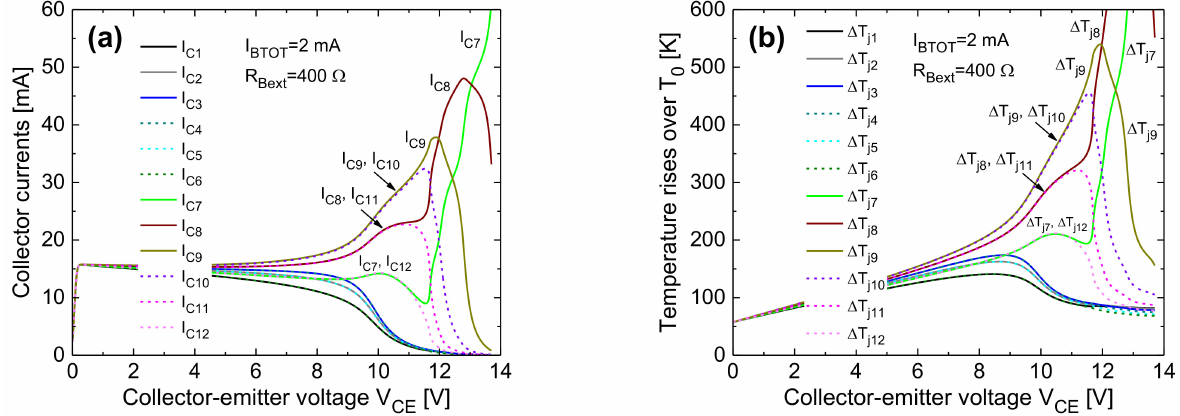
Figure 19. Simulated ( a ) collector currents and ( b ) junction temperature rises above T 0 for the 12 cells of half of the 24-cell array ballasted with R Bext = 400 Ω per cell, and biased with I BTOT = 2